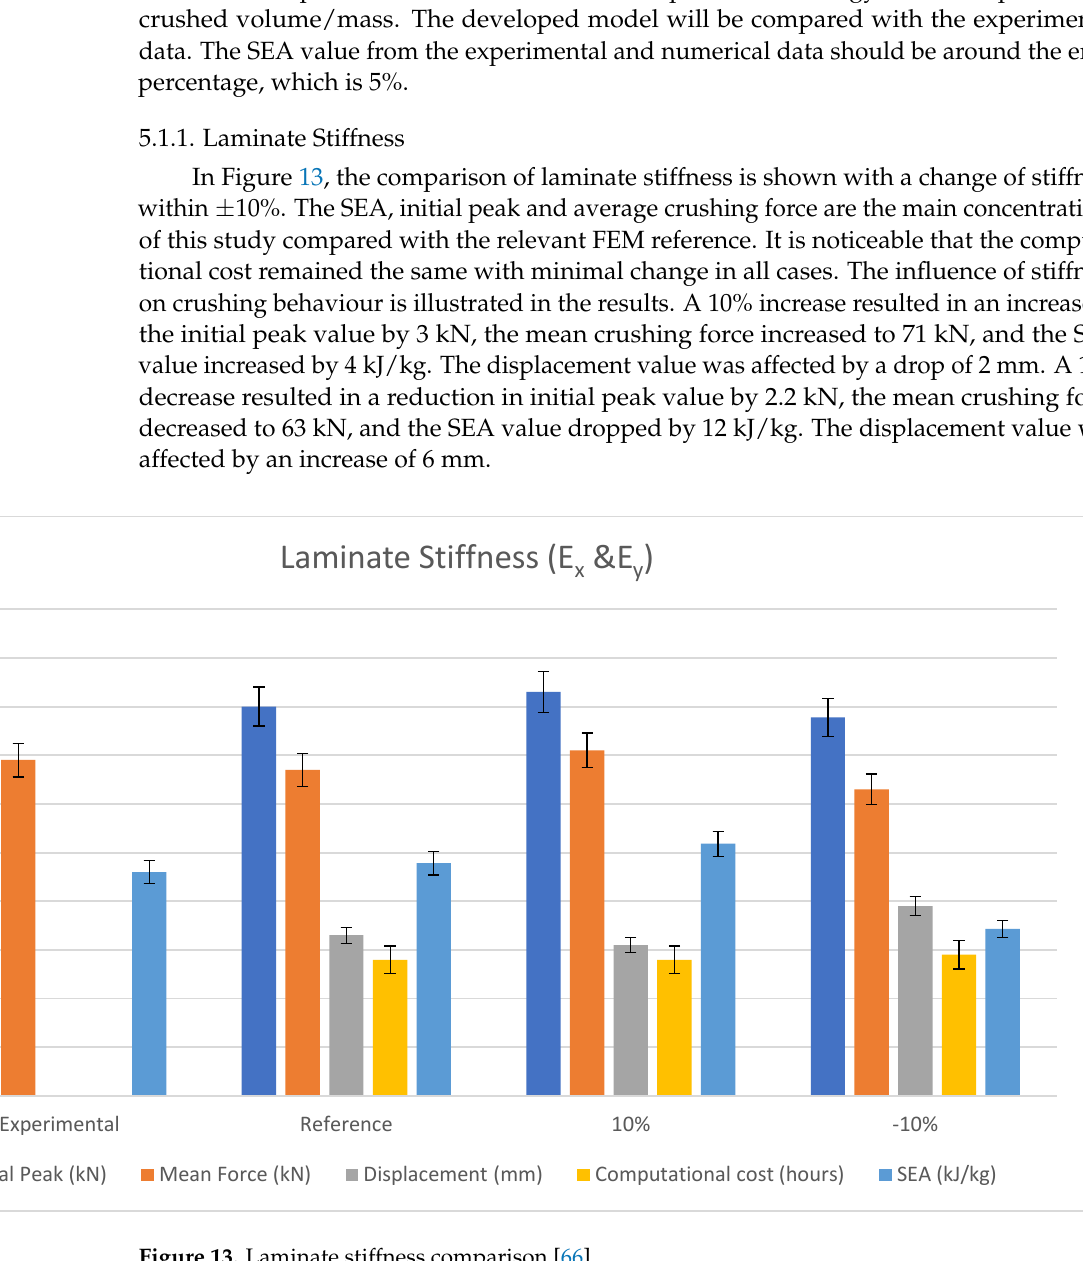
Figure 13. Laminate stiffness comparison [66].